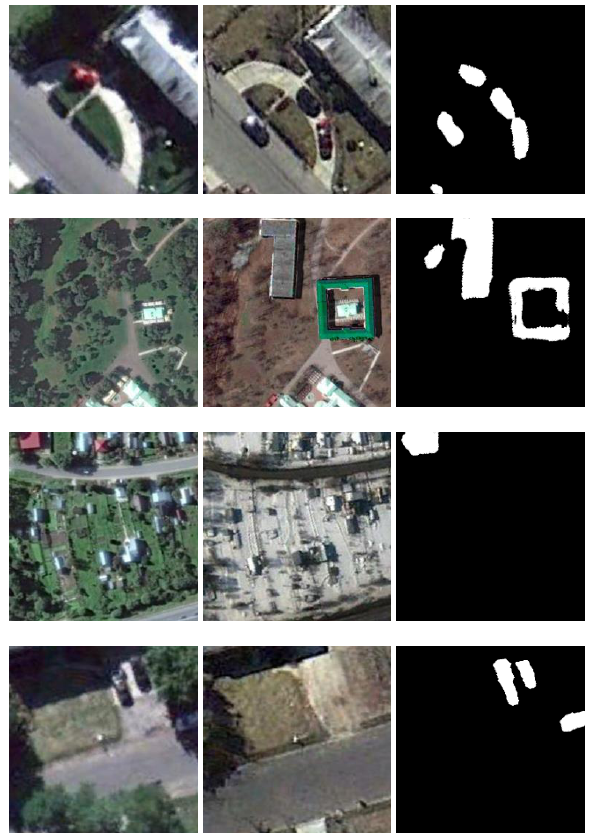
Figure 8. Examples of change detection in remote sensing images: left – input image A, middle – input image B, right – synthesized difference